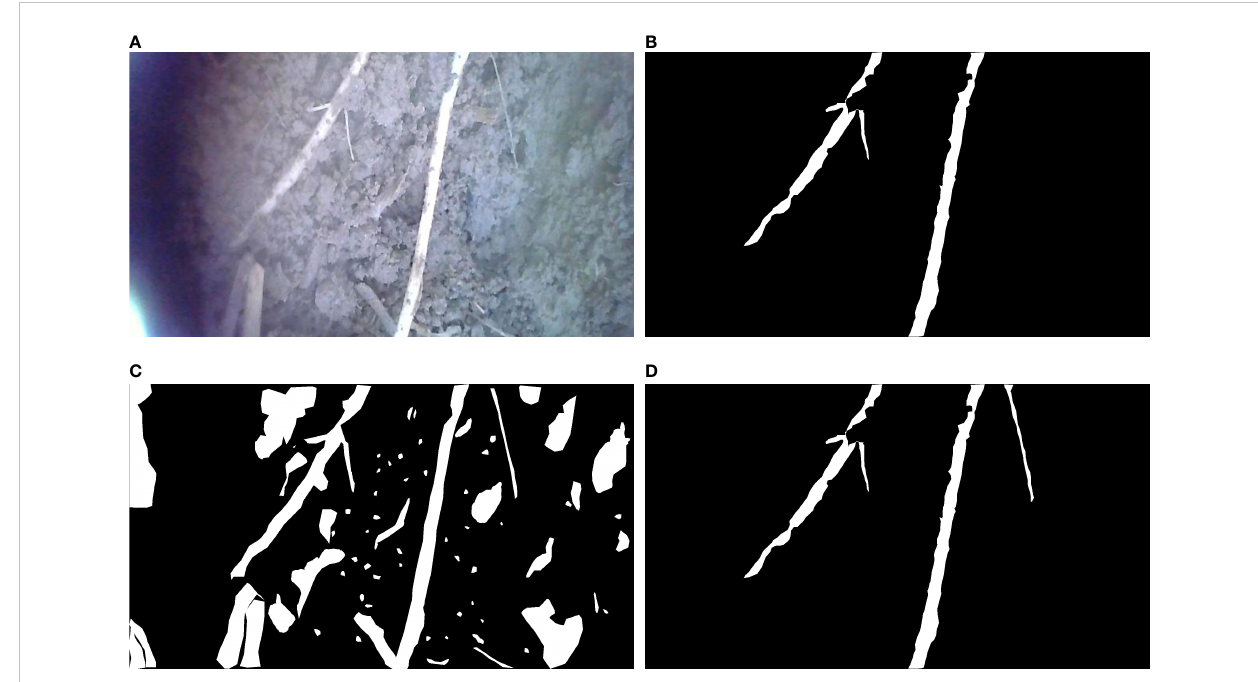
FIGURE 14 The segmentation effect before and after transfer learning. (A) In situ root system, (B) Labeled real msak map, (C) Segmentation effect without using transfer learning, (D) Segmentation effect aftr transferi